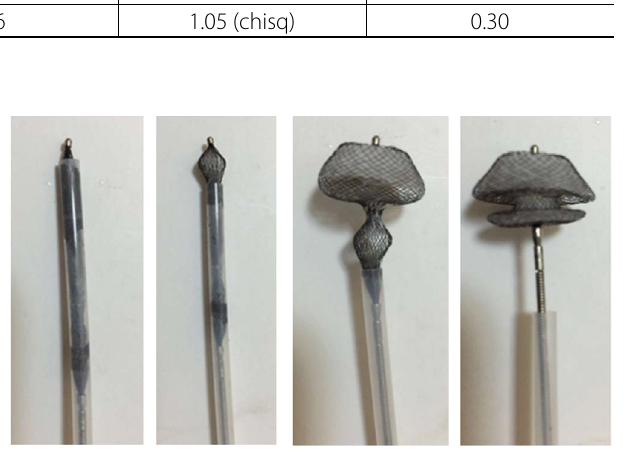
Fig. 1 - Appearance and structure of Lifetech ASD Occluder.